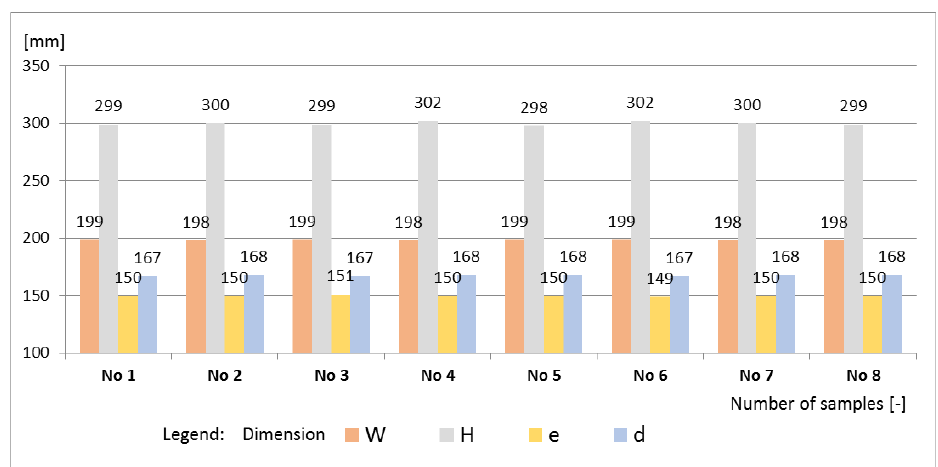
Figure 16. Values of L of the tested curbs.